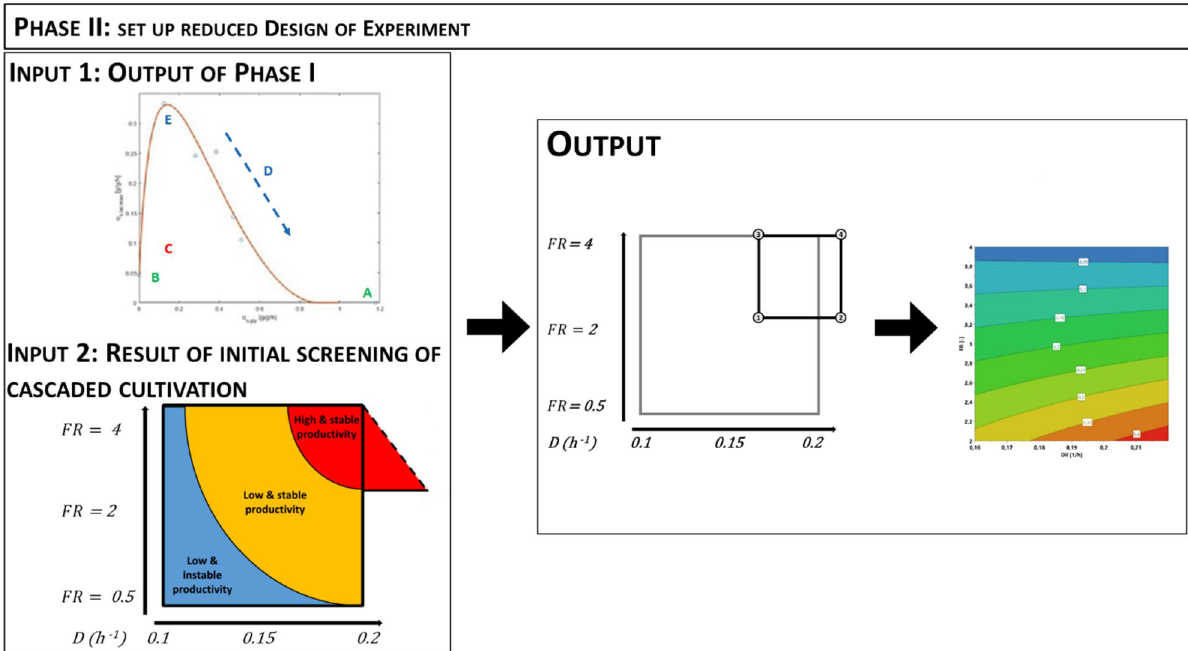
Figure 5. The previous findings of cascaded continuous cultivation are used and combined with the output of Phase I to choose a reduced design space. The obtained constricted design space in phase II accelerates the process to find optimal process conditions ( FR feed ratio, D dilution rate).